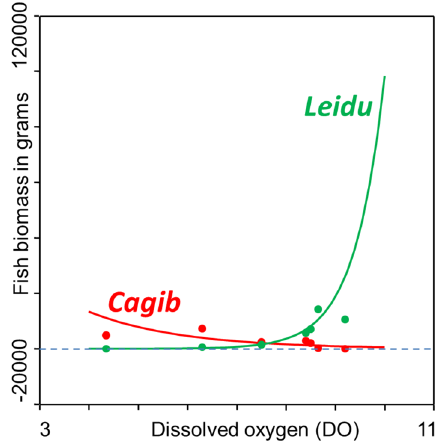
Figure 5. GLM model of the dependence of Carassius gibelio— Prussian carp ( Cagib ) and Leuciscus idus —ide ( Leidu ) biomass on dissolved oxygen in the recovered section of the Ner River, Poland in 2000–2012. Red and green dots are characteristic points of the GLM model. Dissolved oxygen (DO) was measured in mg O 2